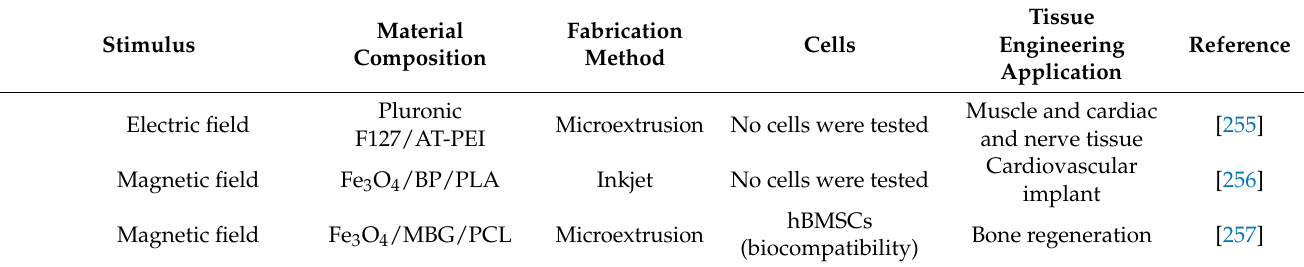
Table 1. Examples of 4D-printed resorbable materials in tissue